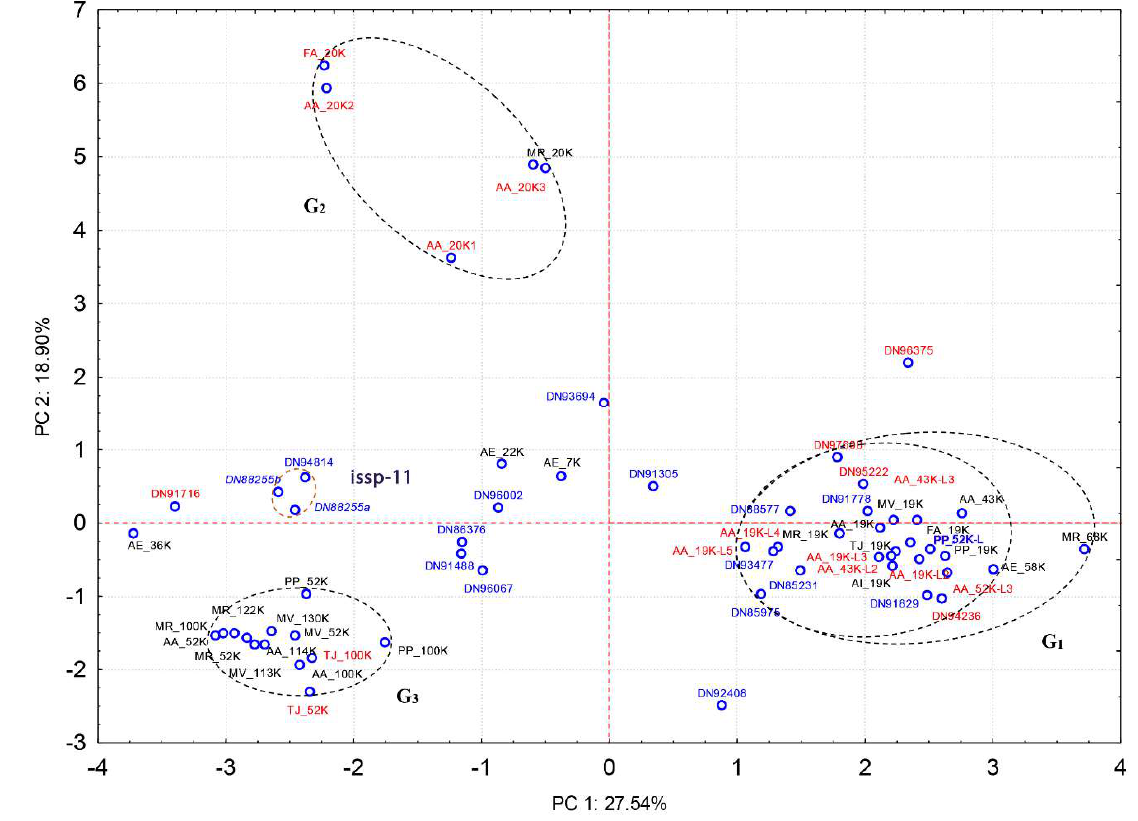
Figure 6. Principal component analysis based on the amino acids’ relative composition of proteins, considering previously characterized cement proteins and those proteins found during the present study, which was not possible to annotate through BLAST or conserved domains. The proteinGroups previously defined, corresponding to surface couple proteins CP19k, − 43k, − 58k, and − 68k (G1) and CP20k (G2), and bulk proteins CP52k and − 100k [19]. No unannotated proteins were found close to previously defined groups G2 and G3, but many were leaned to those of G1. The two principal components (PC) extracted explain 45.77% of the total variability of data. Blue – complete unannotated sequences; Red – incomplete unannotated sequences or incomplete cement proteins previously characterized; black – cement proteins (CPs) previously